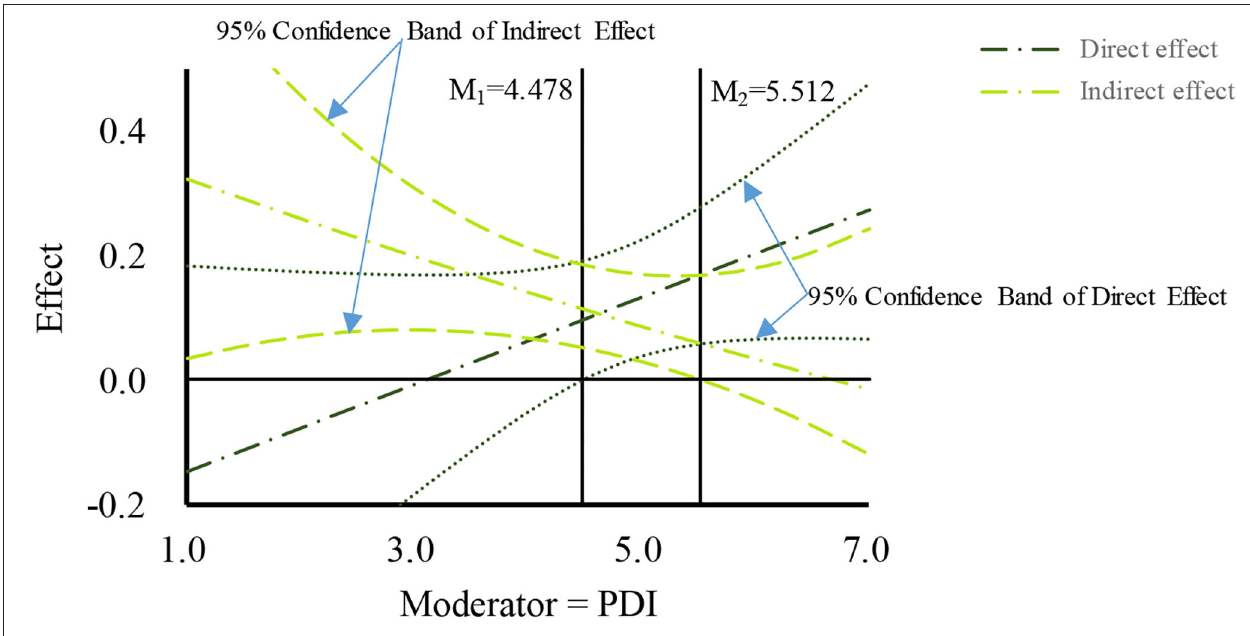
FIGURE 3 | Moderated mediation effect of product display.